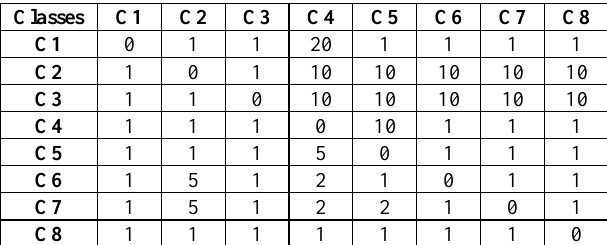
Figure 7and its corresponding confusion matrix and accuracy assessment is provided in Table6.